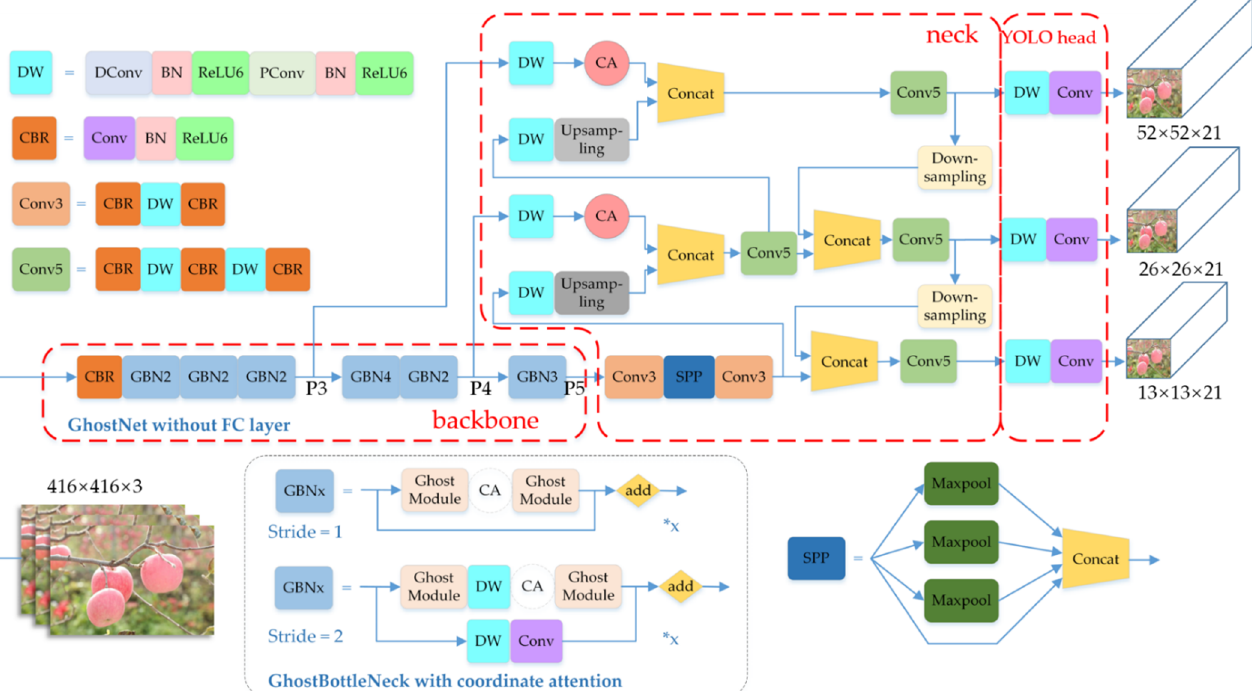
Figure 4. Improved YOLOv4 network. The Ghost Module in the backbone uses the ReLU activation function, while the rest of the network structures use the ReLU6 activation function. CA module means Coordinate Attention. The CA module in GhostBottleNeck is only present in the GBN structures at layers 4, 5, 10, 11, 12, and 14. The symbol “*x” indicates the GBNx is composed of x GBN